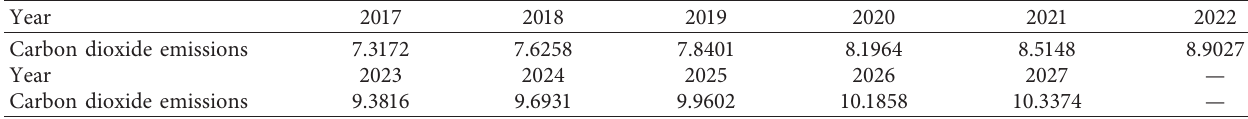
Table 9: Prediction data (metric tons/person).